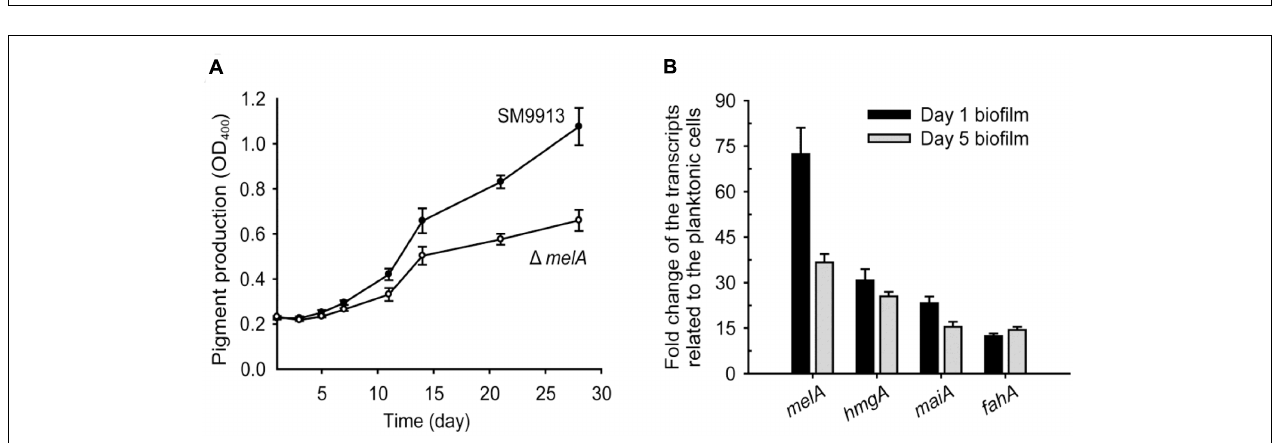
FIGURE 2 | Pyomelanin production is induced at higher temperatures in SM9913. (A) Pigment production of SM9913 cultured in SWLB at different temperatures on days 1, 2, and 5. Three independent cultures were tested and one representative image is shown. (B) Protein profiles of SM9913 grown at 15 and 37 ◦ C for 24 h in SWLB. Arrows indicate the protein band that selected for mass spectrometry analysis. (C) Fold change of the hsp90 , melA , hmgA , maiA, and fahA transcription in SM9913 at 37 ◦ C compared to the condition at 15 ◦ C quantified by qRT-PCR. Overnight cultures were diluted to OD 600 ∼ 0.1 and re-grown until OD 600 ∼ 1 at 15 ◦ C. Cells were collected before and after transfer to 37 ◦ C for 25 min. (D) Pigment production of SM9913 and (cid:49) melA strains cultured at 37 ◦ C. (E) Pigment production of SM9913 and (cid:49) melA strains with exogenous SM9913 melA gene expression ( (cid:49) melA /pBBR1MCS-Cm- melA ) or with an empty plasmid ( (cid:49) melA /pBBR1MCS-Cm) at 37 ◦ C for 2 days measured at OD 400 . Data are the average of three independent cultures, and one standard deviation is shown in (C–E) .